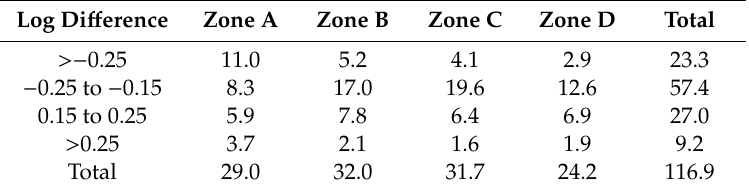
Table 6. Zonal statistics using the synthesis of the VH and VV polarizations for each log di ff erence threshold and zone (Zone A to Zone D). Areas are measured in hectares (10,000 m 2